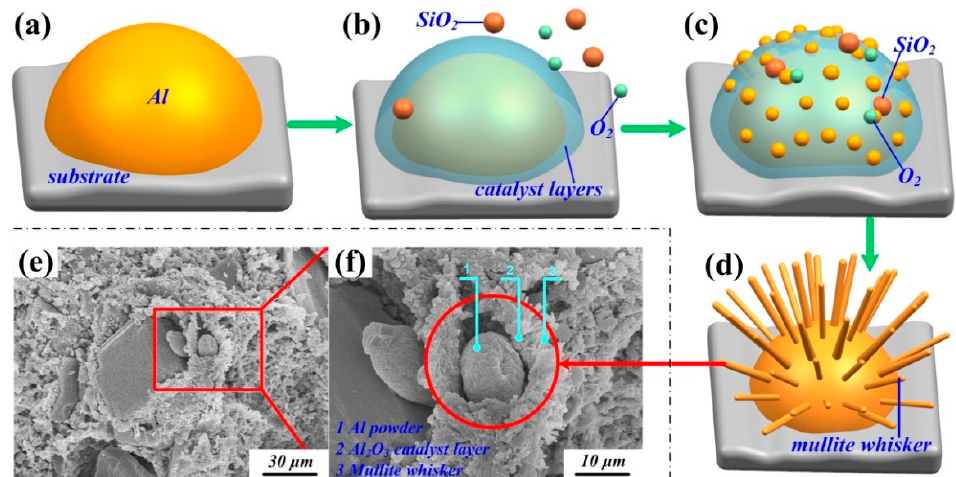
Figure 2. ( a – d ) Vapor–liquid–solid (VLS) growth process of mullite whiskers; ( e ) Scanning electron microscopy (SEM) morphology of SiO 2 ceramic; ( f ) Microstructure of SiO 2 ceramic.